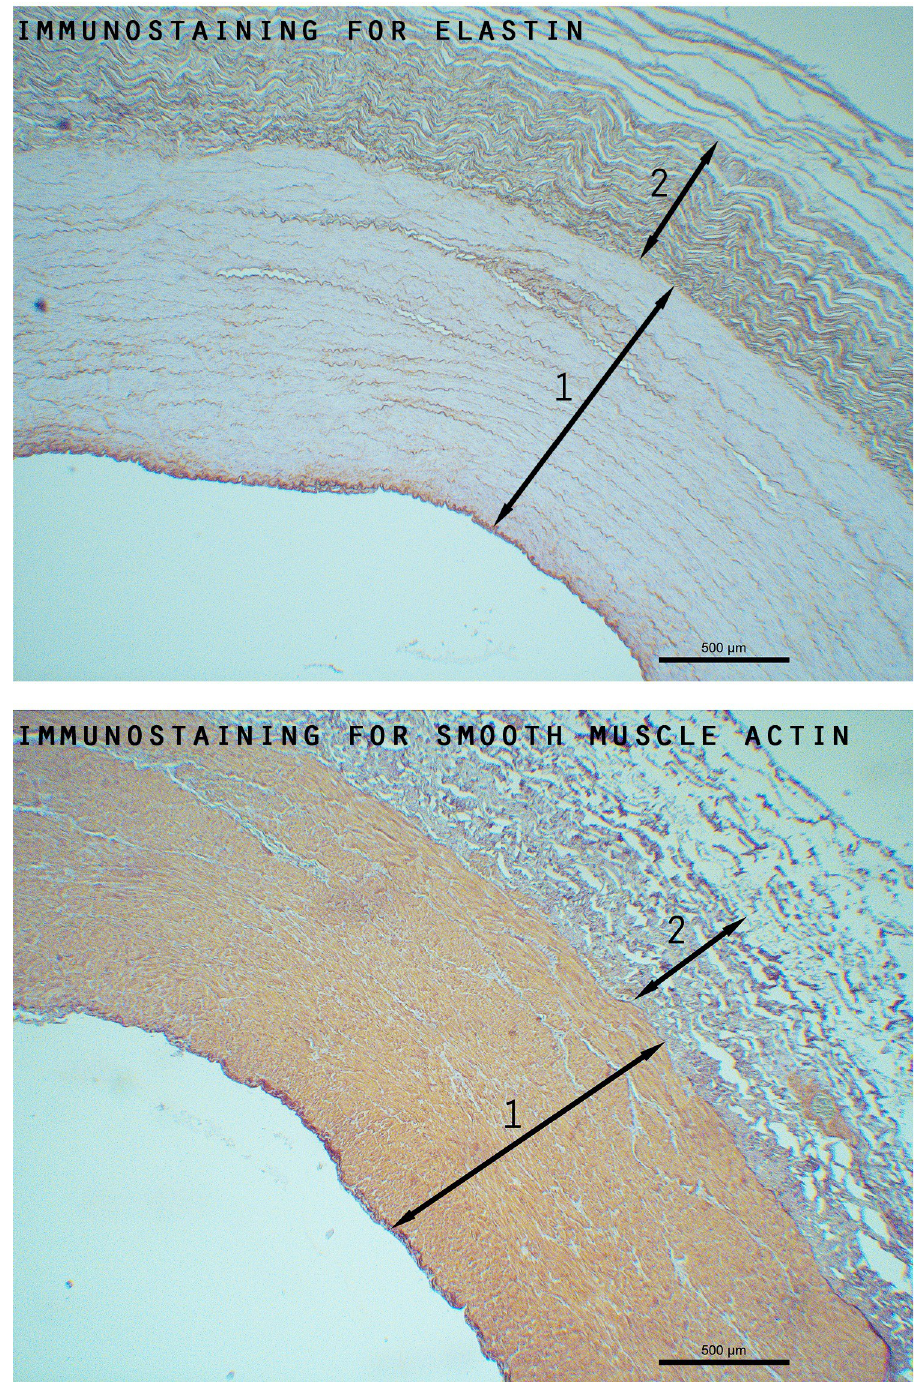
Fig 4. Immunostaining for elastin and smooth muscle actin of the caudal common carotid artery, showing two clearly distinguishable layers: Layer 1 (1) consisting mainly of smooth muscle cells and layer 2 (2) consisting predominantly of elastin